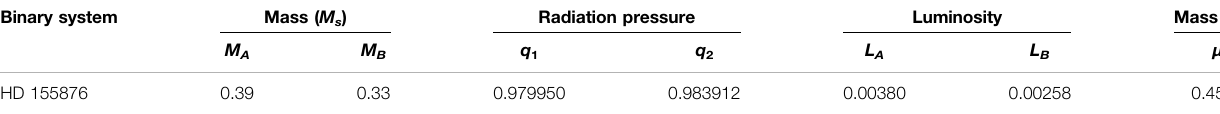
TABLE 1 | Numerical data for the binary HD155876 system (Singh et al., 2018). Binary system Mass ( M s